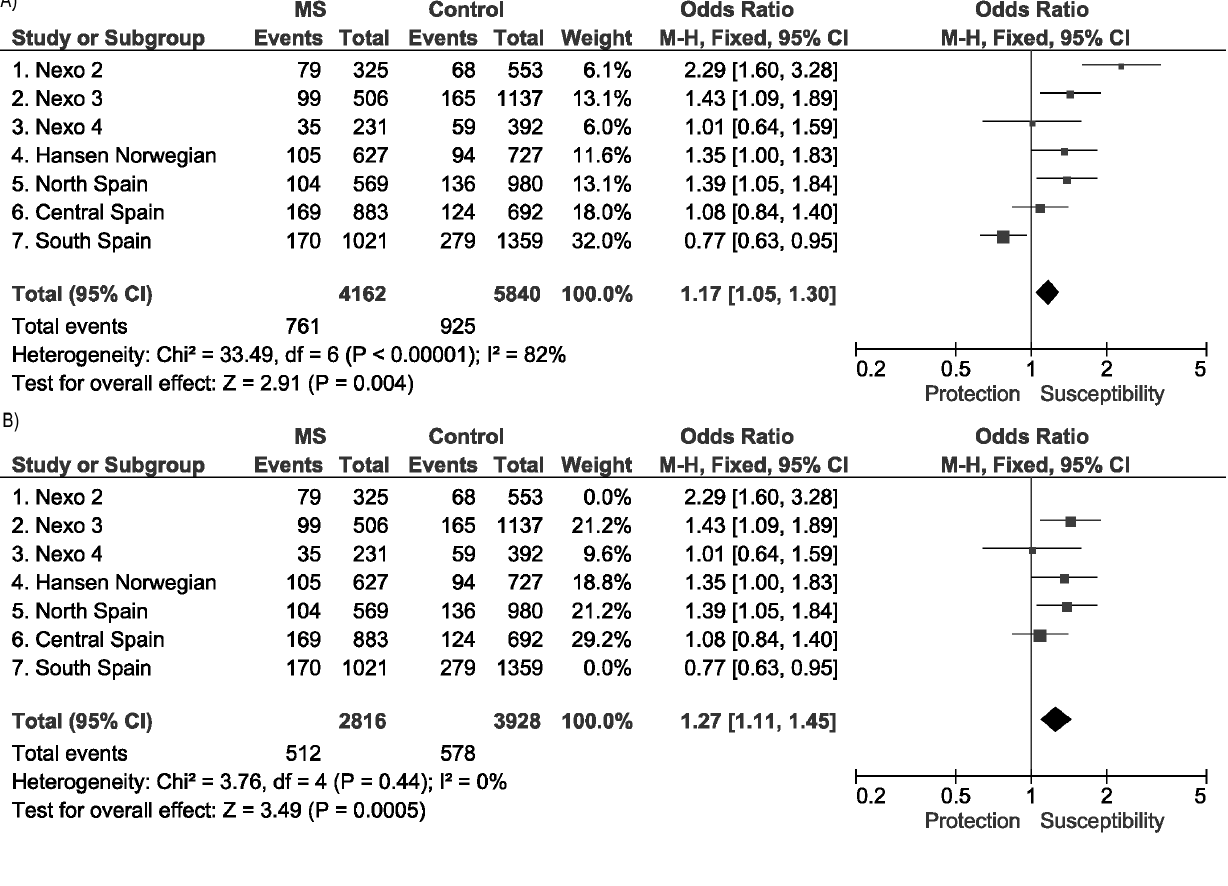
Figure 1. Meta-analysis including the studies of HERV-Fc1 association with MS published previously and those performed in the Spanish cohorts. Forest plot showing the overall data (A) and after eliminating heterogeneity by removing the Southern Spanish cohort (B).